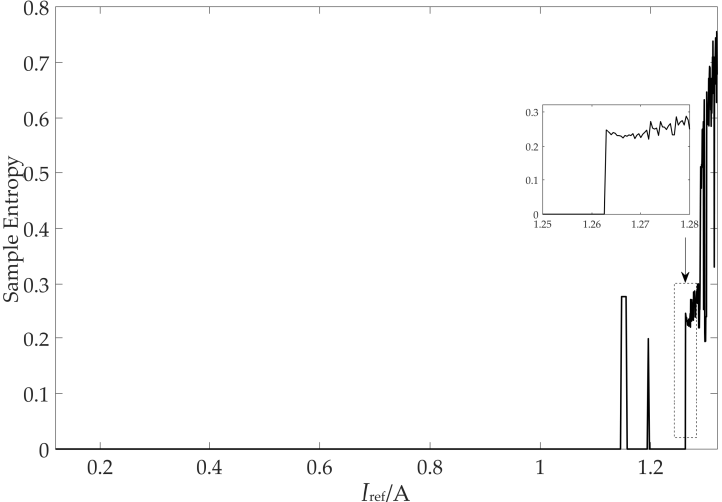
Figure 9. Sample Entropy of buck converter with I ref as the change parameter Figure 10. Sample Entropy of buck converter with I ref as the change